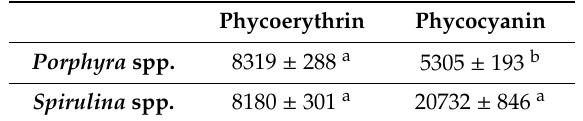
Table 4. Phycoerythrin and phycocyanin contents of Porphyra spp. and Spirulina spp. extracted